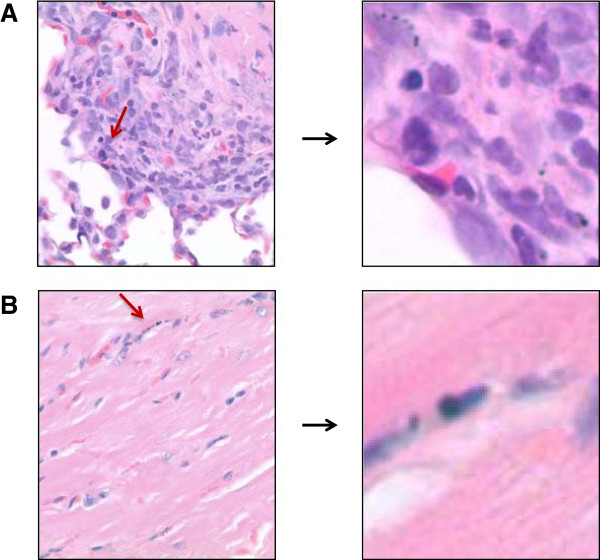
Pigment in lung and heart. A: The image on the left is from a 14-day-PEG-HAuNS-treated animal with peribronchiolar inflammation. Arrow points to pigment. B: Arrow points to pigment in lung tissue from a 90-day-PEG-HAuNS-treated animal. Magnification: ×400.